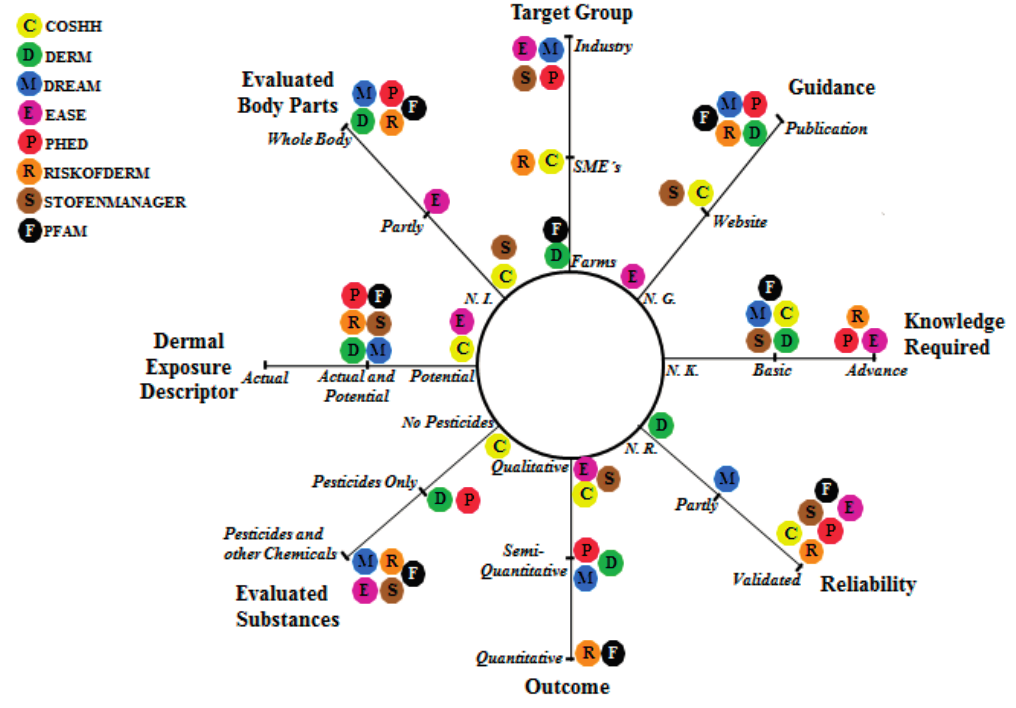
Figure 1. Radar diagram with the multi-criteria analysis for the evaluated models for dermal exposure assessment (NI: Not Included; NG: No Guidance; NK: No Knowledge Required; NR: Not